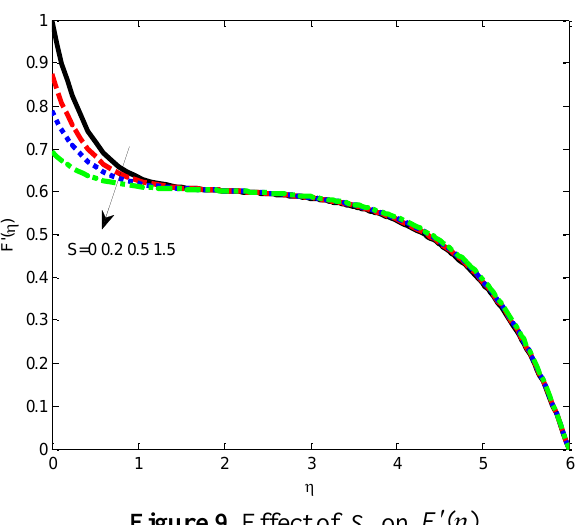
Figure 9. Effect of S